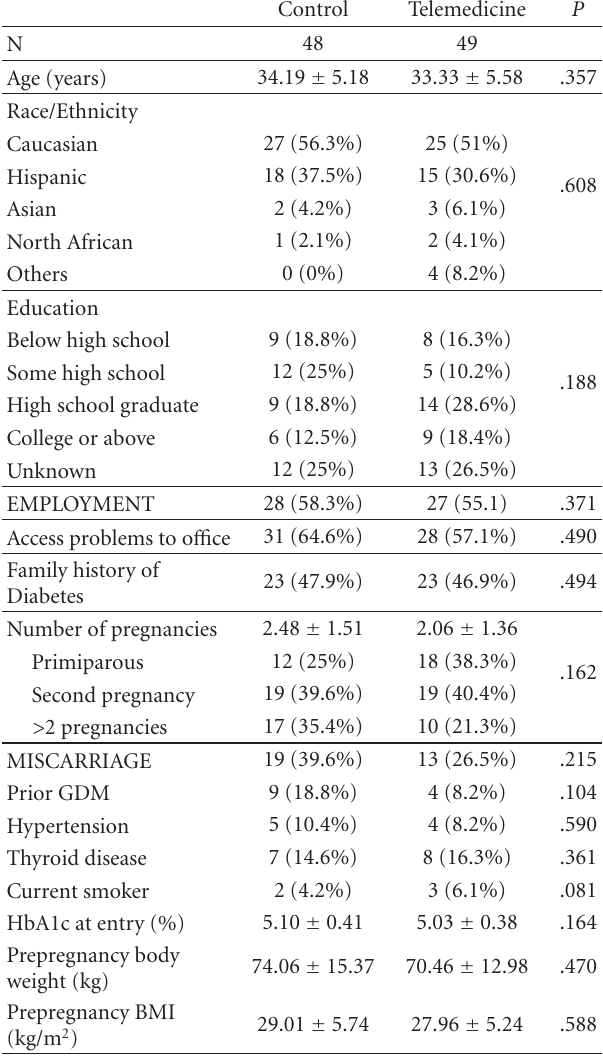
Table 1: Characteristics of the survey population by